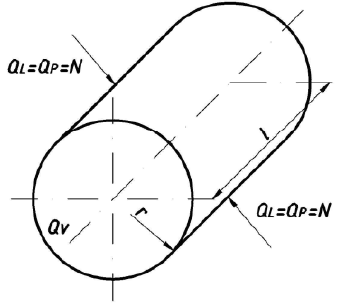
Figure 13. Scheme of the sample and heat fluxes.